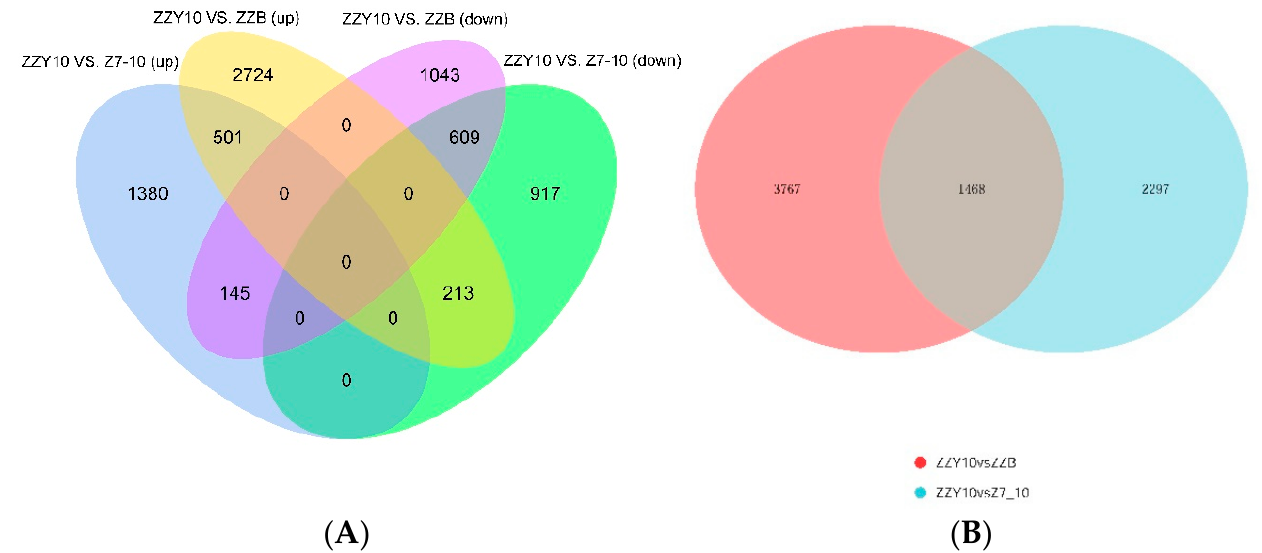
Figure 1. Venn diagram of DG HP . ( A ) Number of up-regulated and down-regulated genes expressed in two cross combinations; ( B ) Number of genes expressed in two cross combinations. When comparing the expression levels of all the DEGs in ZZB, Z7-10, and ZZY10, we found a composite expression pattern, including five sub-patterns: over-dominance, additivity, low-parent dominance, high-parent dominance, and under-dominance, which suggested multiple modes of action (Table 3). The percentages of up-regulated, additivity, and down-regulated genes in DG HP are 35.6%, 38.8%, and 25.6%, respectively. As shown in Figure 2 and Table 3, the distributions of DG HP are over-dominance (28.9%), high-parent dominance (6.7%), additivity (38.8%), low-parent dominance (2.1%), and under-dominance (23.5%). First, the majority of DG HP exhibits additivity. Second, the percentages of over- dominant DG HP and under-dominant DG HP are 28.9% and 23.5%, respectively (Figure 2 and Table 3). Finally, the percentages of additivity, over-dominance, and under-dominance account for 91.2% of all DG HP (Figure 2 and Table